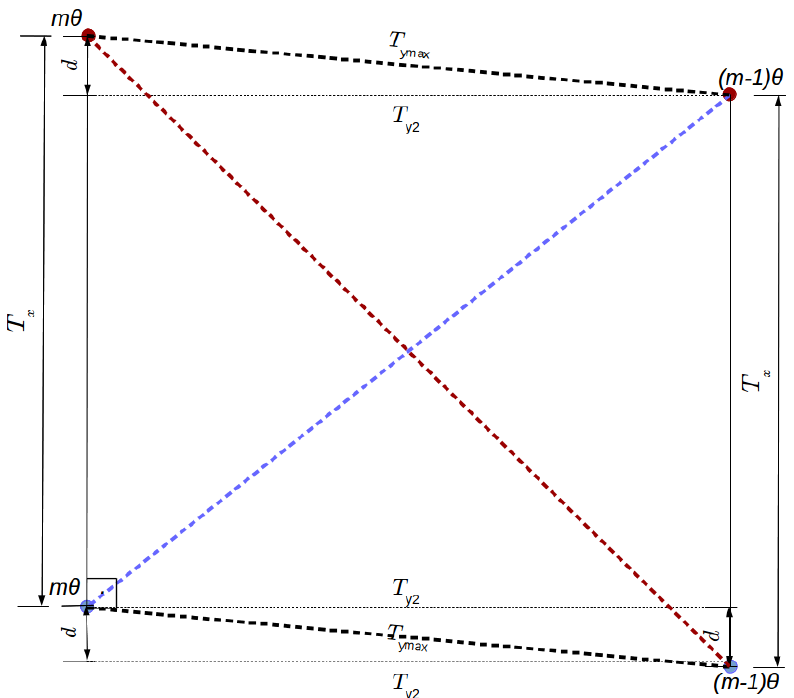
Figure 5. Distance between pair of sensor readings which are closest to the corner, m θ and ( m − 1 ) θ angular positions, during the first sensor revolution are displayed as blue vertices, while the same samples at the next revolution are in red. Note that they form a parallelogram of sides T x and T y with the largest distance between samples at the parallelogram at the largest diagonal, shown in red dashed